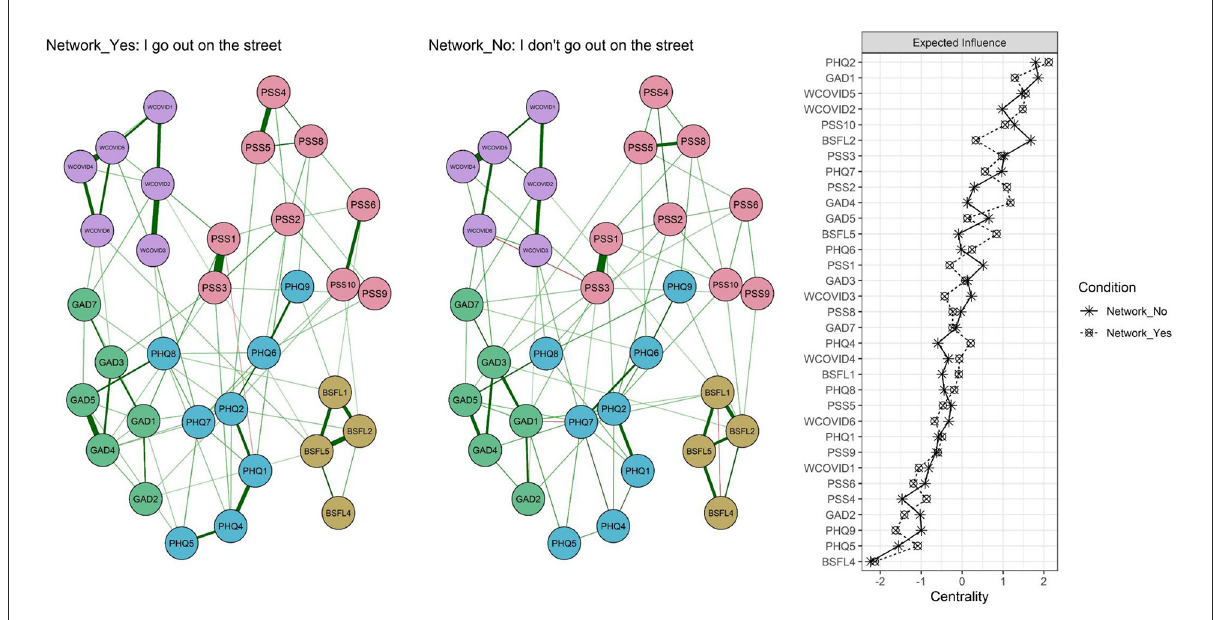
FIGURE4 Networks relating to going out or not during lockdown and centrality